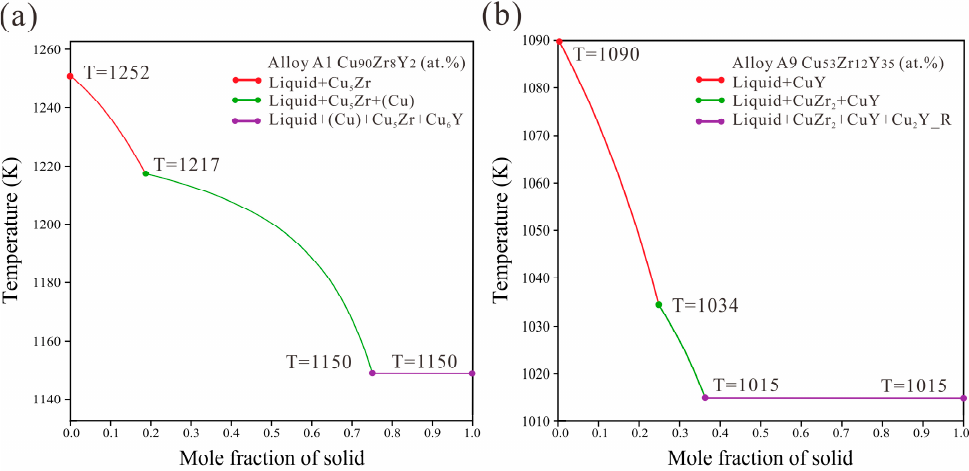
Figure 13. The Scheil simulation for alloys A1 Cu 90 Zr 8 Y 2 (at.%) ( a ) and A9 Cu 53 Zr 12 Y 35 (at.%) ( b ).